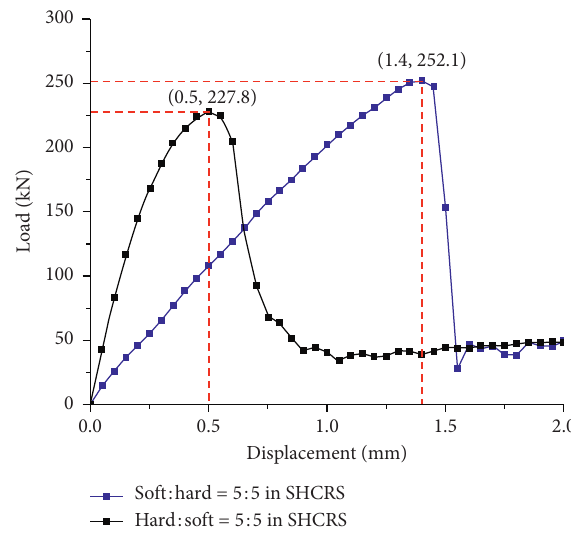
Figure 12: Load-displacement comparison curves in SHCRS and